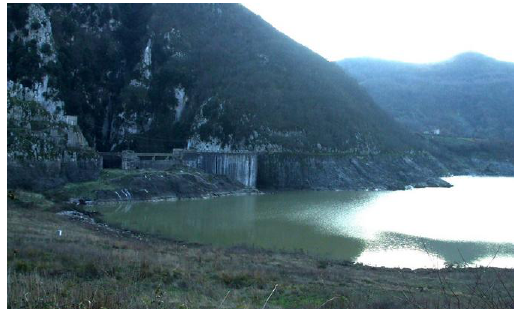
Figure 8. Upstream view of the Muro Lucano (PZ)